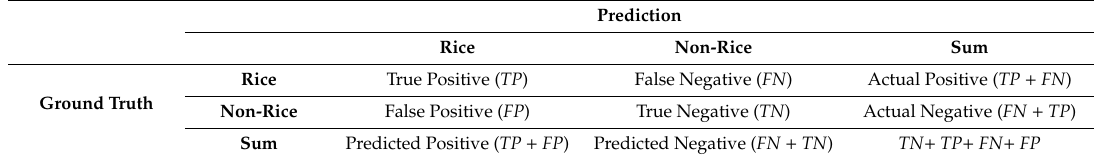
Table 3. Confusion